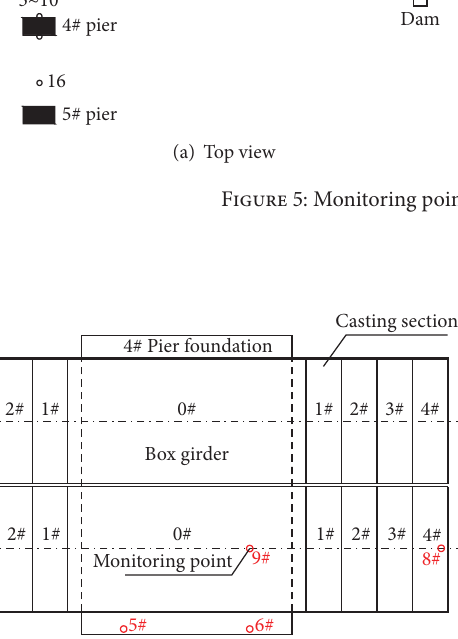
schedule to compare vibration response of different extended length of box girder.